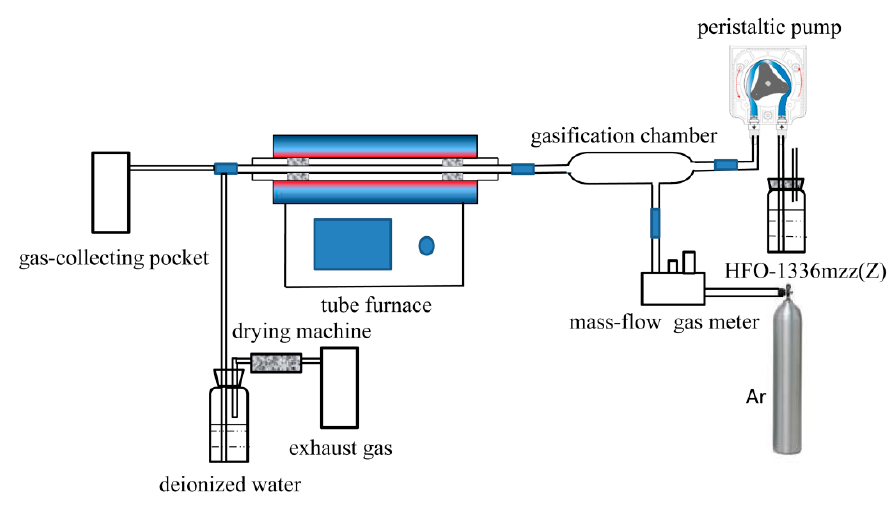
Figure 20. Schematic diagram for the HFO-1336mzz(Z) pyrolysis system.